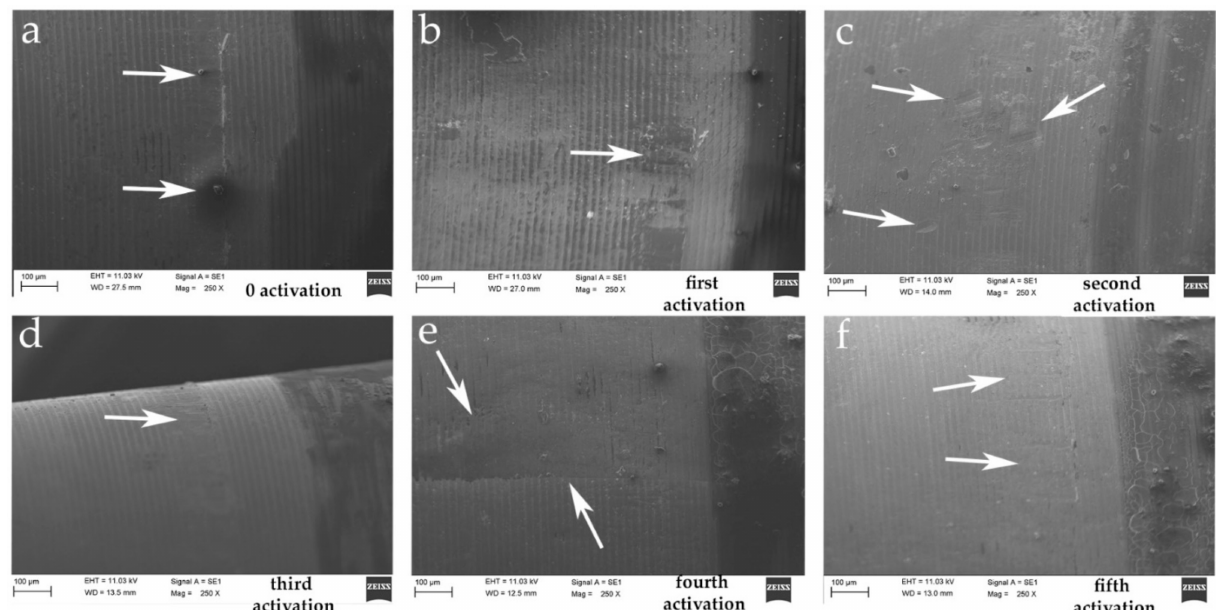
Figure 4. SEM images at higher magnification (250 × ). ( a ) No activation. Arrows show an irregularity into the interior part of abutment never activated. ( b–f ) From first to fifth activation, an increase in vertical streaks is visible on the abutments (white arrows). This can be interpreted as points of greater friction of the connection.